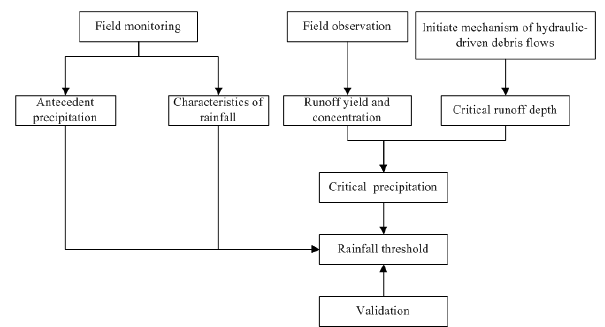
Figure 8. The flow chart of the